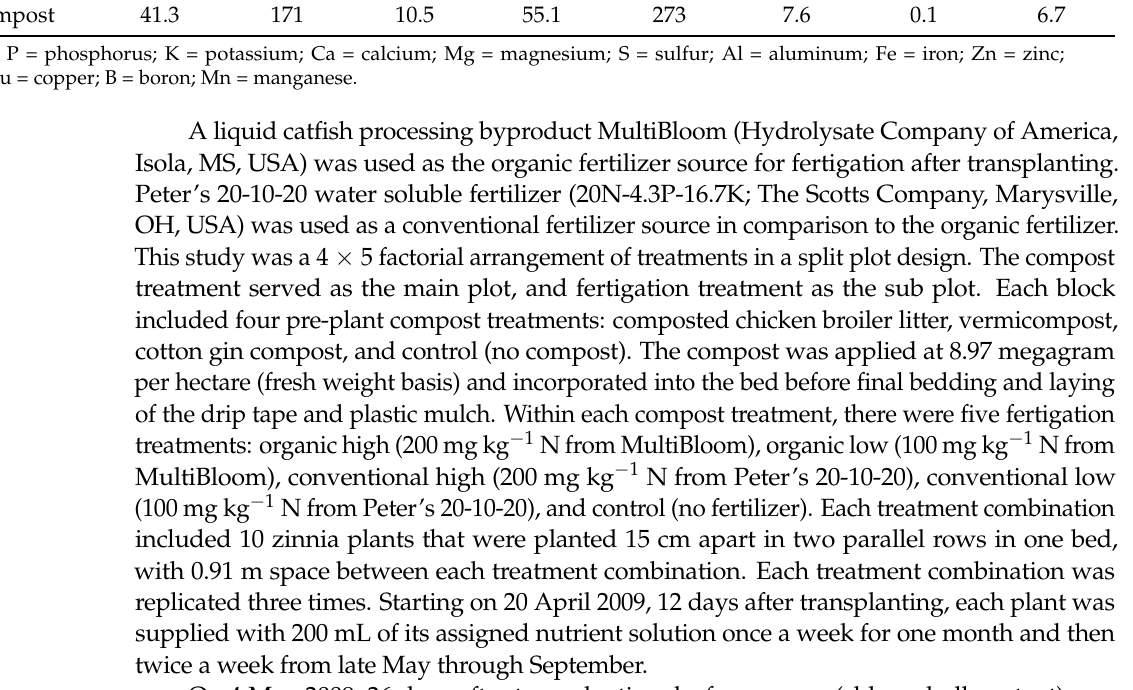
A liquid catfish processing byproduct MultiBloom (Hydrolysate Company of America,